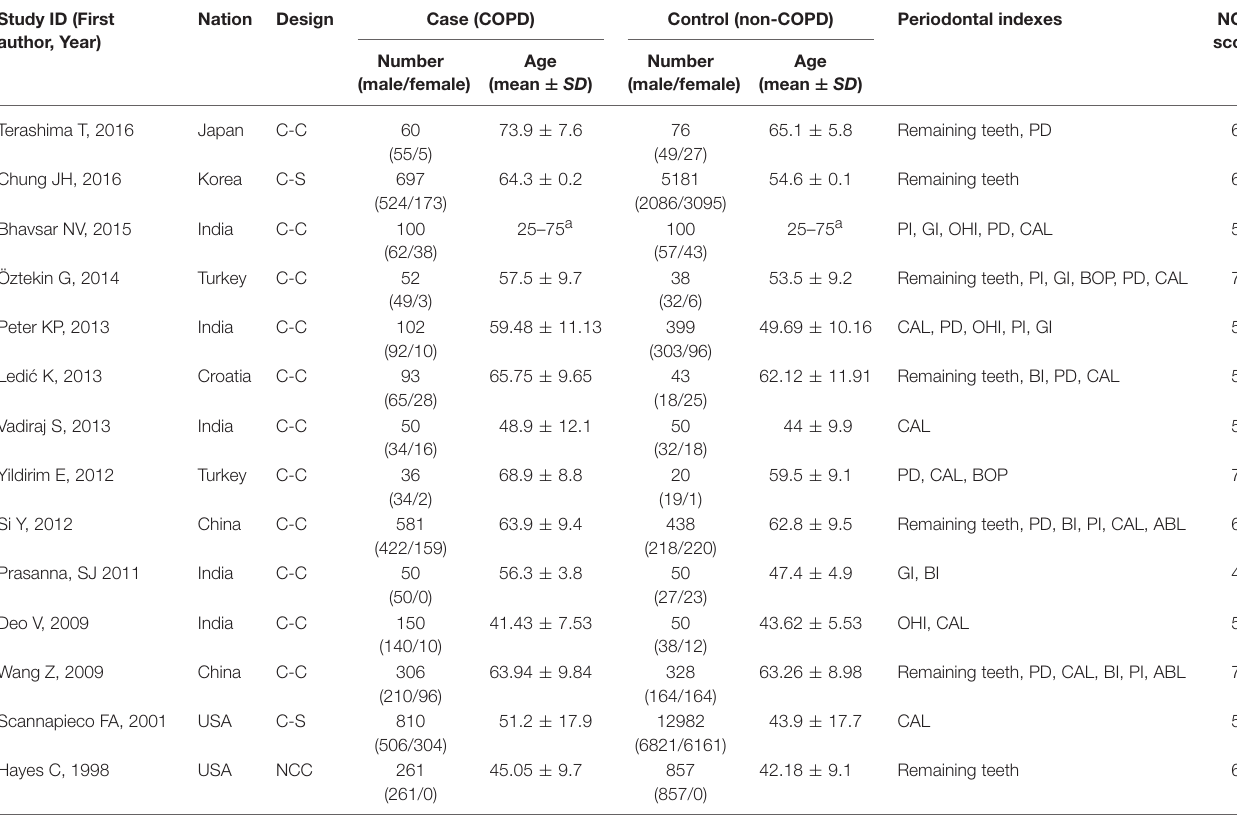
TABLE 1 | Characteristics of included